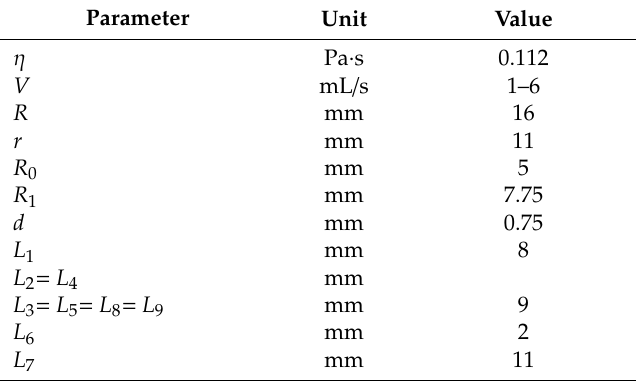
Table 2. List of parameters used for valve